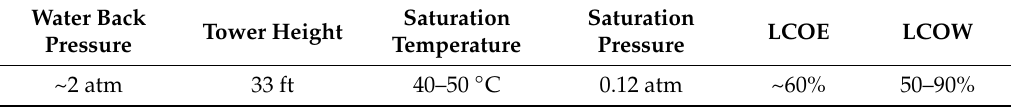
Table 3. Operational parameters for the proposed design in comparison with conventional distillation .